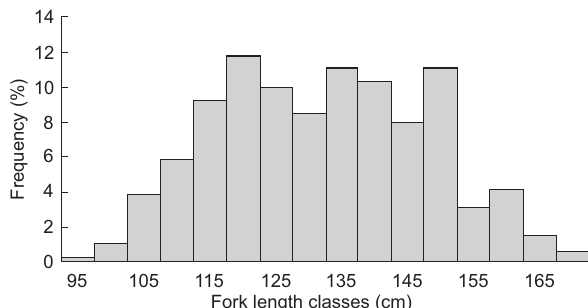
Figure 4. Relationship between dressed weight (DW) and fork length (FL) of yellowfin tuna in the eastern and central Pacific Ocean from February to November